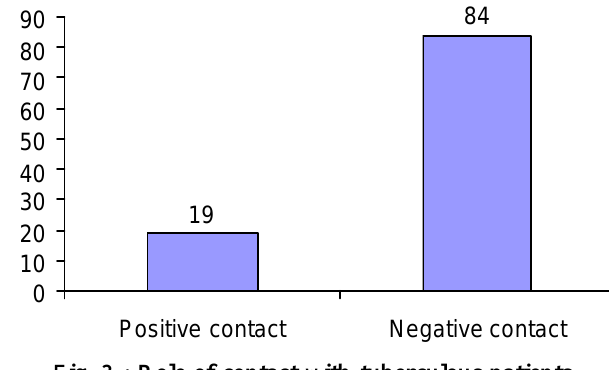
Fig. 3 : Role of contact with tuberculous